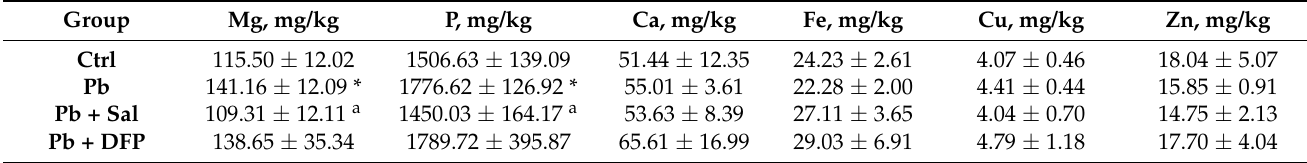
Table 1. Concentrations of essential elements in the brains of experimental mice. Data are presented as mean +